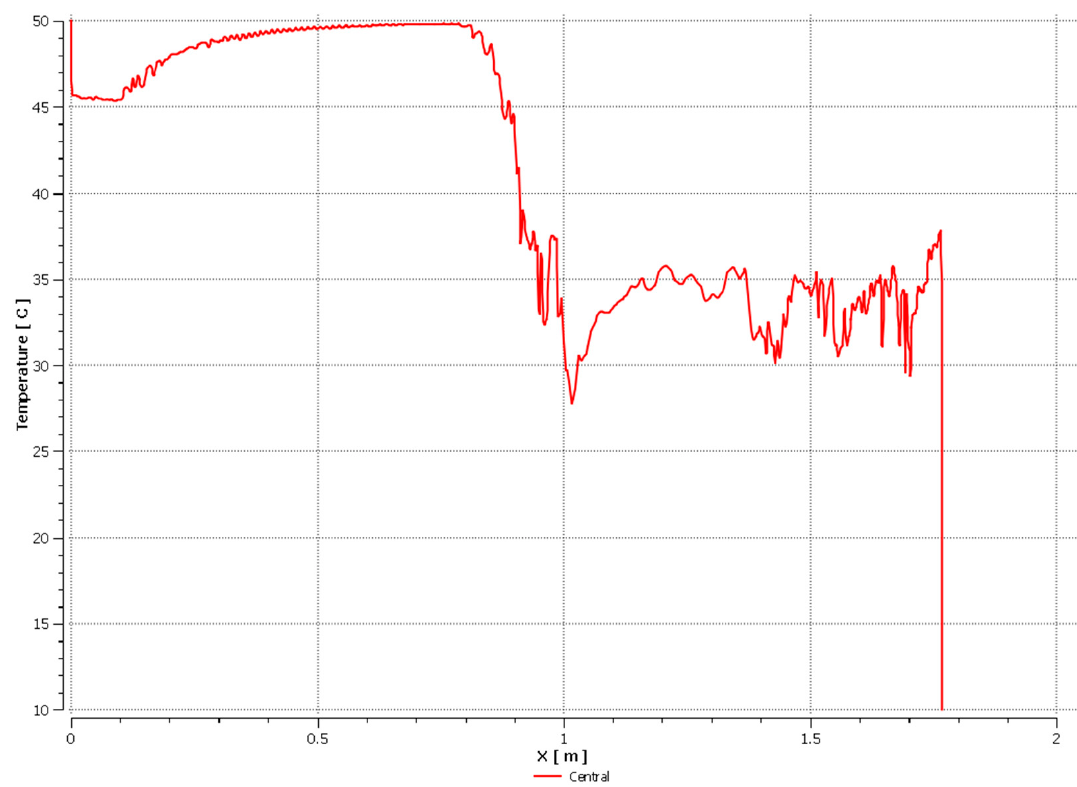
Figure 9. Temperature distribution along the height on the heat pipe’s central line.